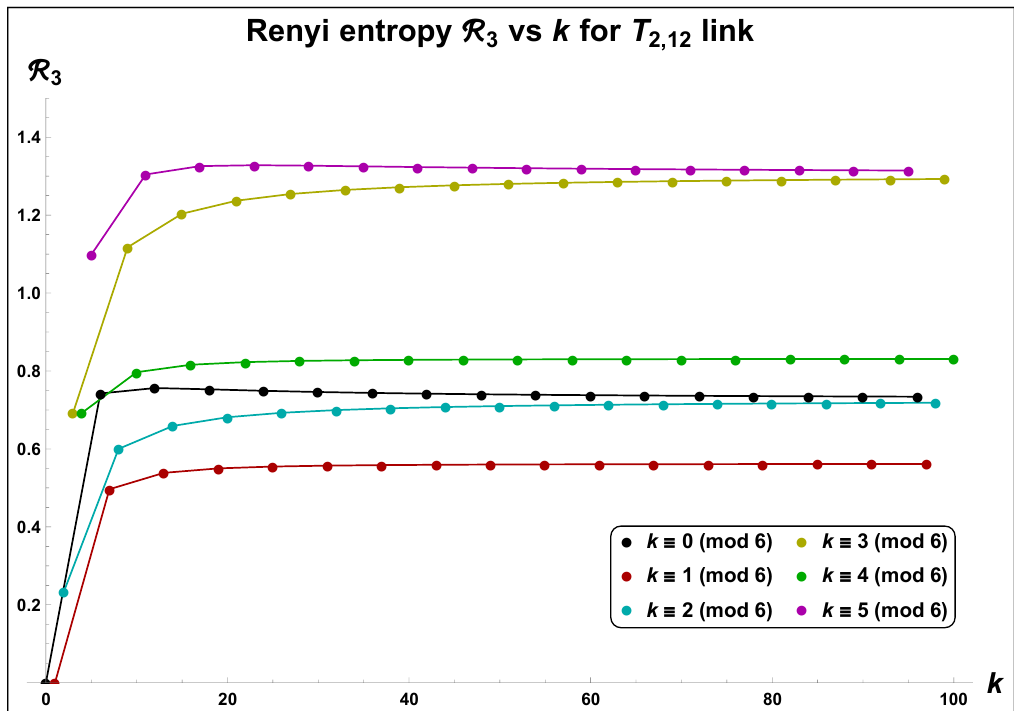
Figure 5. The variation of the third Rényi entropy R 3 with k computed for SU (2) k group. The state under consideration is | T 2 , 12 i . The entropy has been plotted for various values of k modulo